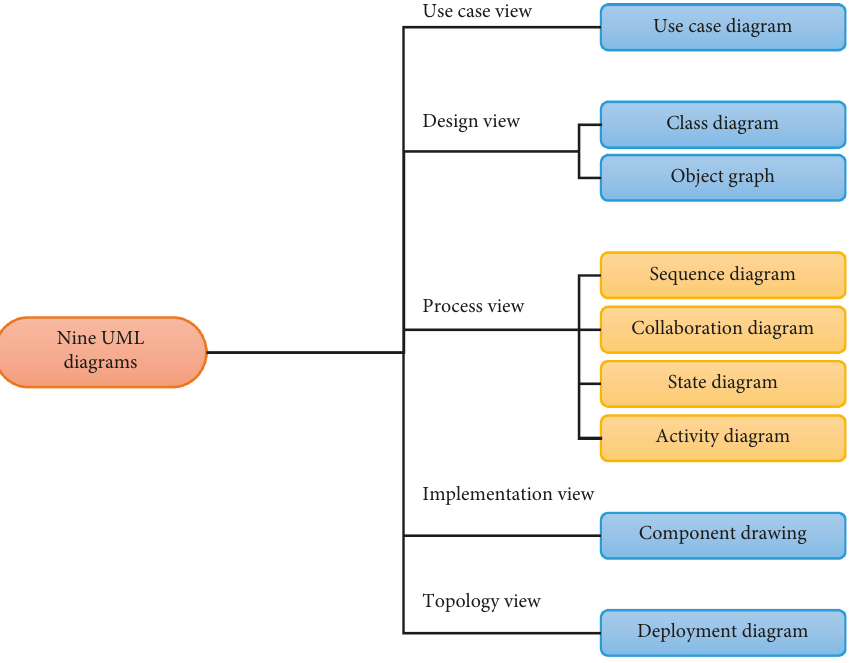
Figure 10: Tool Table 1: Description properties of users’ behavior.